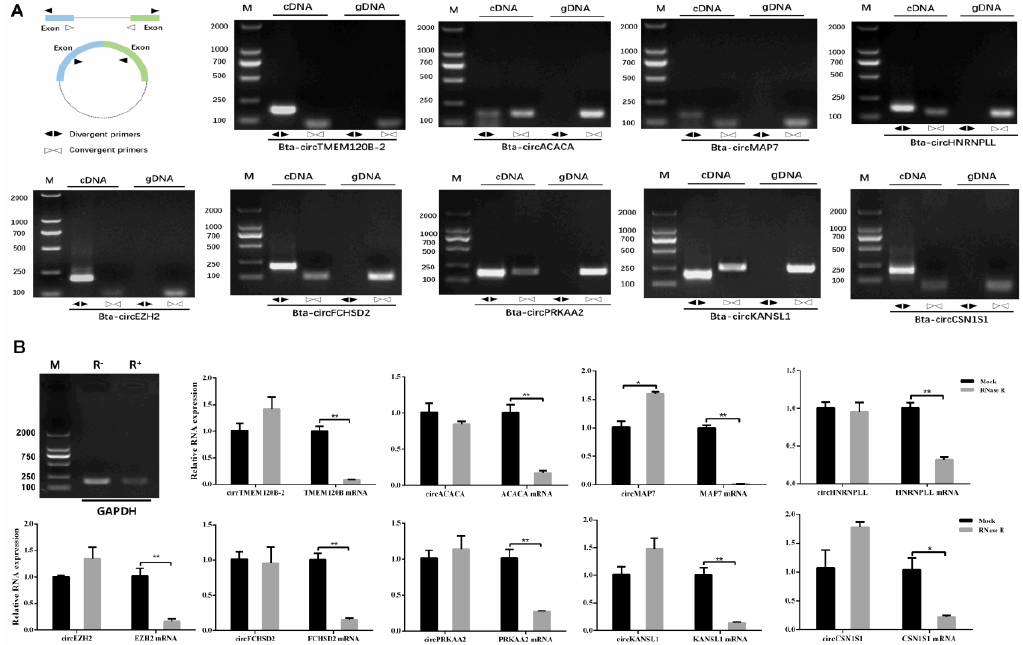
Figure 4. Characterization of circRNA candidates. ( A ) identification of circRNA candidates by divergent and convergent primers; Divergent primers amplify circRNA candidates in cDNA but not genomic DNA, and convergent primers amplify targets in both cDNA and genomic DNA. ( B ) RT-qPCR for the abundance of circRNA and their hosting mRNA treated with RNase R.